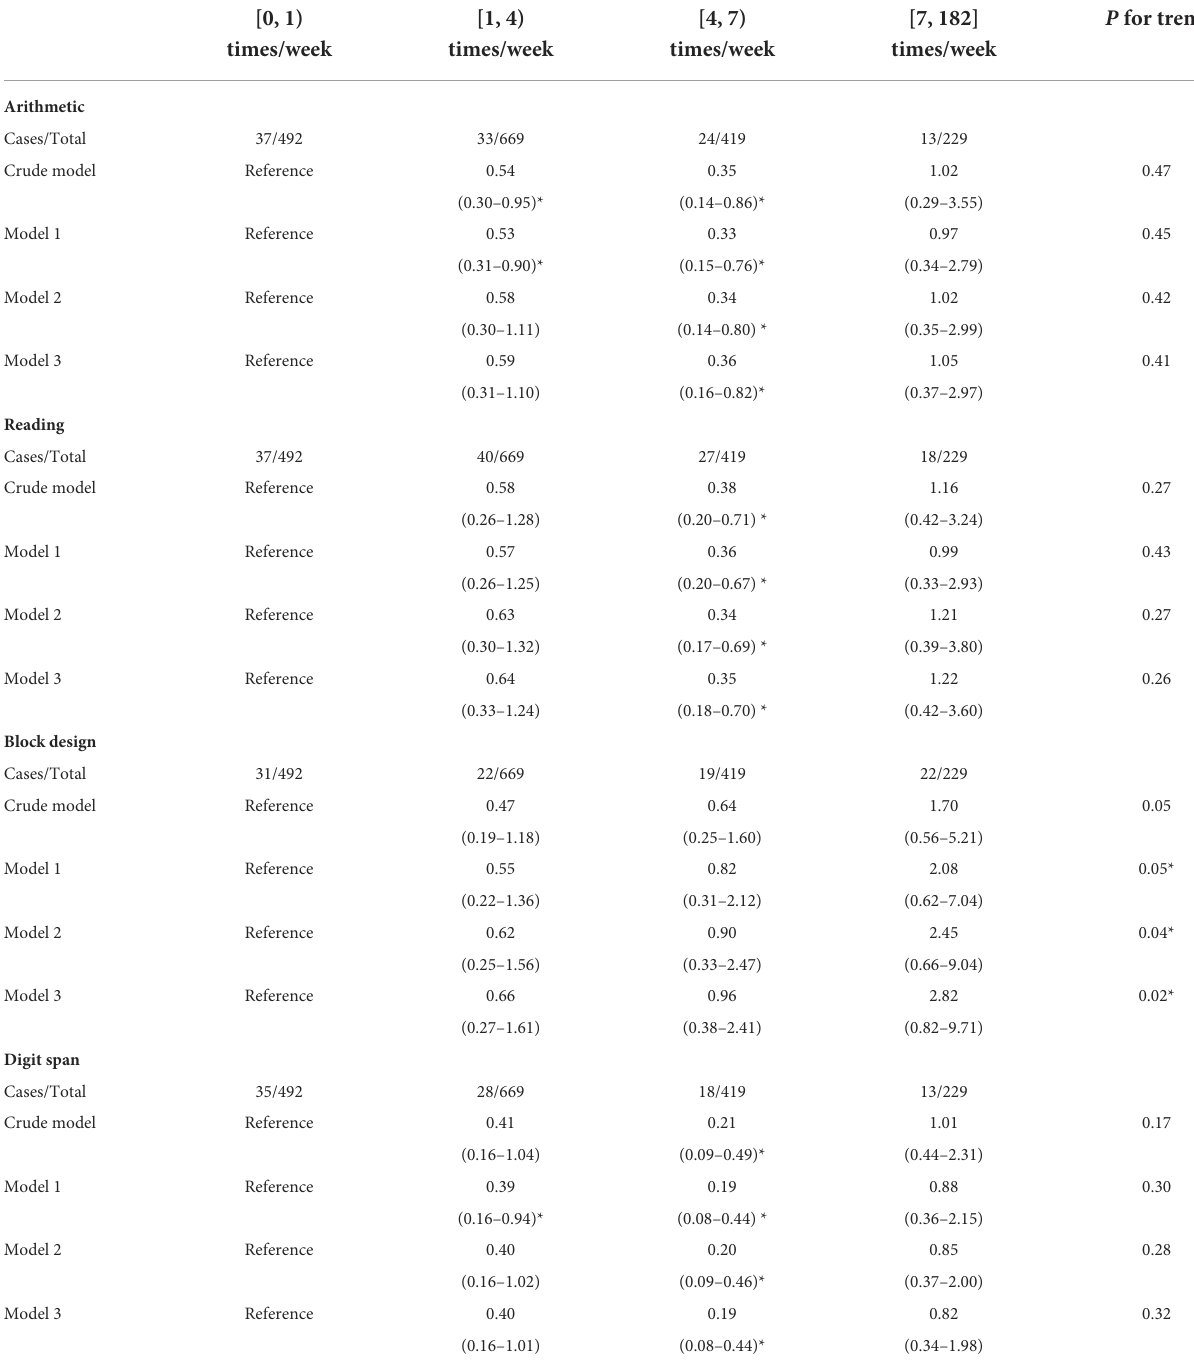
TABLE 2 Association of intake of SSBs with cognitive tests in adolescents aged 12–16 years in the United States: NHANES III,